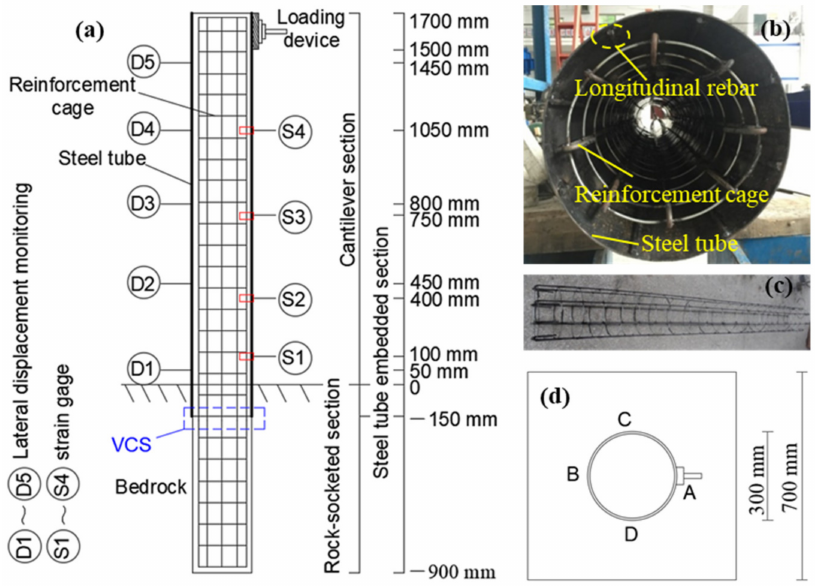
Figure 2. The preparation of specimens: ( a ) RSCFST specimen and the arrangement of monitor; ( b ) The steel tube, longitudinal rebar, and reinforcement cage of the RSCFST; ( c ) The reinforcement cage; ( d ) Top view of the